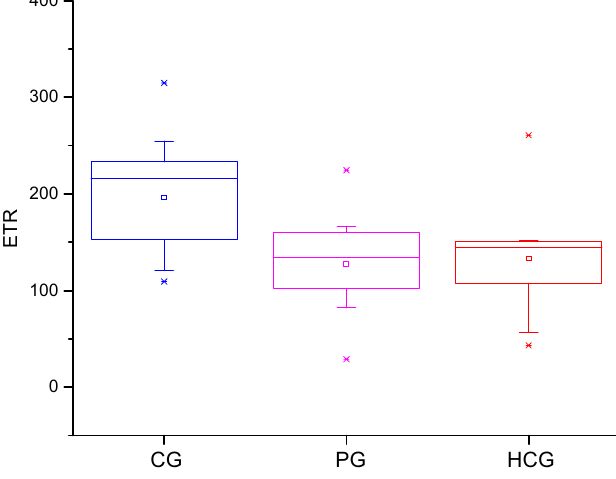
FIGURE 5 - “Box-plot” graphic of ranging total rupture energy by group